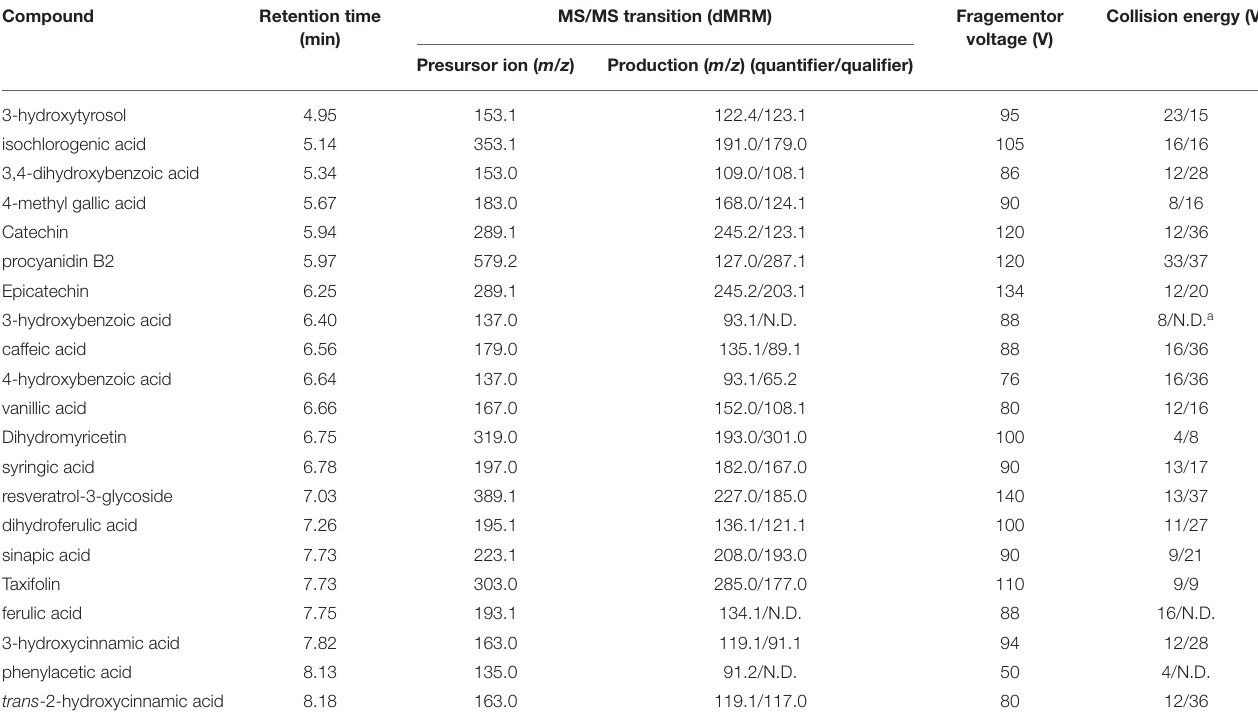
TABLE 2 | The information for dynamic multiple reactions of monitoring (dMRM) parameters.